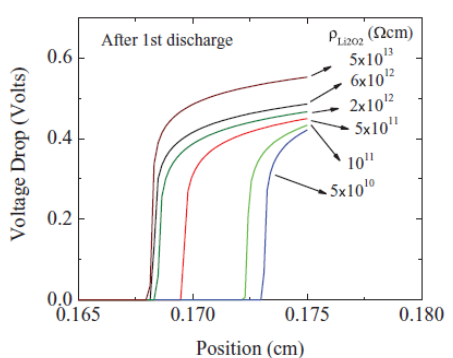
Figure 9. The ohmic potential drop across the Li 2 O 2 layer as a function of position in the cathode after the first discharge (when the cell voltage reaches 2 V). Republished from Chen et al. [19] with permission of The Electrochemical Society, conveyed through Copyright Clearance Center, Inc.